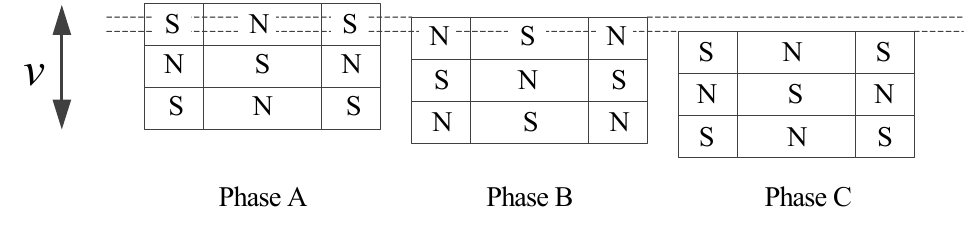
Figure 2. Stator lamination of the TFPMLM: ( a ) lamination; and ( b ) model of the stator core.